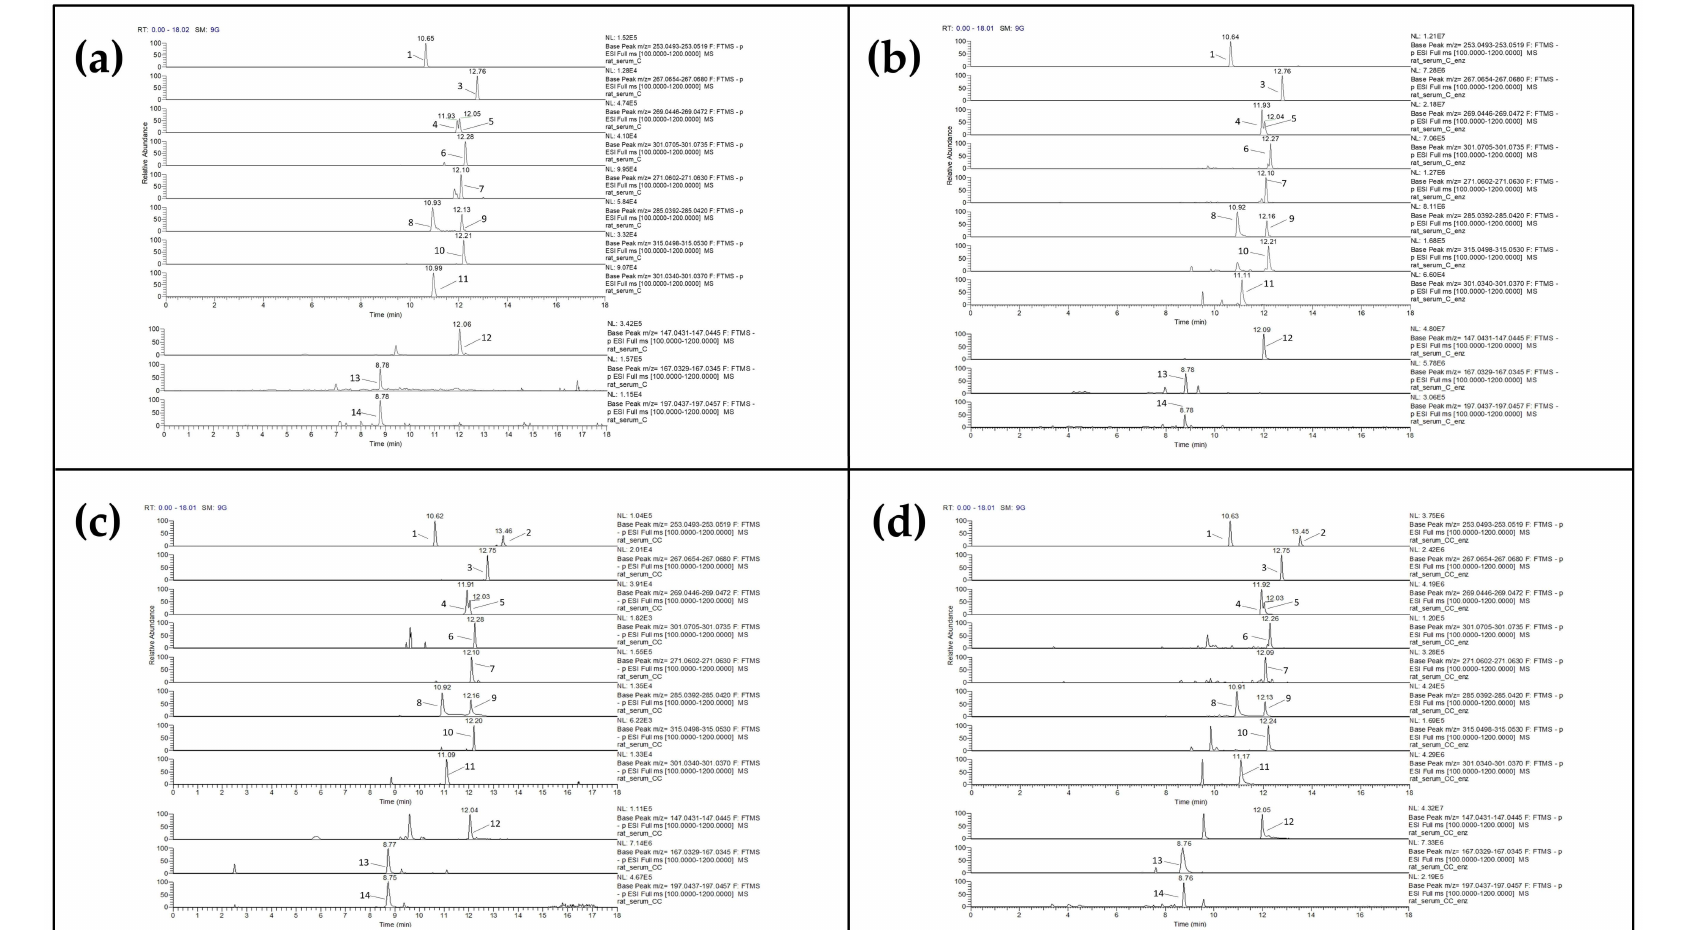
Figure 1. Extracted ion chromatograms (XICs) of polar phenolic compounds detected in rat serum from ( a ) the control group, ( b ) the control group that underwent enzymatic hydrolysis, ( c ) the Corinthian Currant supplemented group and ( d ) the Corinthian Currant supplemented group that underwent enzymatic hydrolysis. Peaks: (1) daidzein, (2) chrysin, (3) formononetin, (4) apigenin, (5) genistein, (6) hesperetin, (7) naringenin, (8) luteolin, (9) kaempferol, (10) isorhamnetin, (11) quercetin, (12) trans-cinnamic acid, (13) vanillic acid and (14) syringic